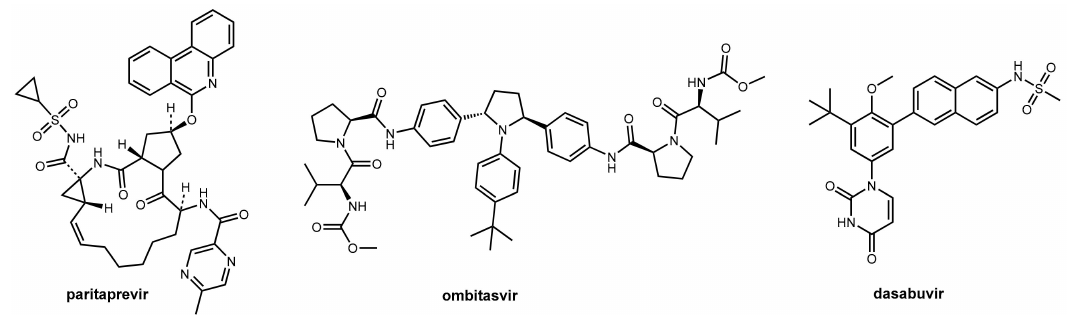
Figure 13. Structures of novel direct-acting antiviral drugs paritaprevir (NS3/4A protease inhibitor), ombitasvir (inhibitor of the non-structural protein NS5A involved in viral replication, assembly, and release of HCV particles), and dasabuvir (inhibitor of the RNA polymerase NS5B).